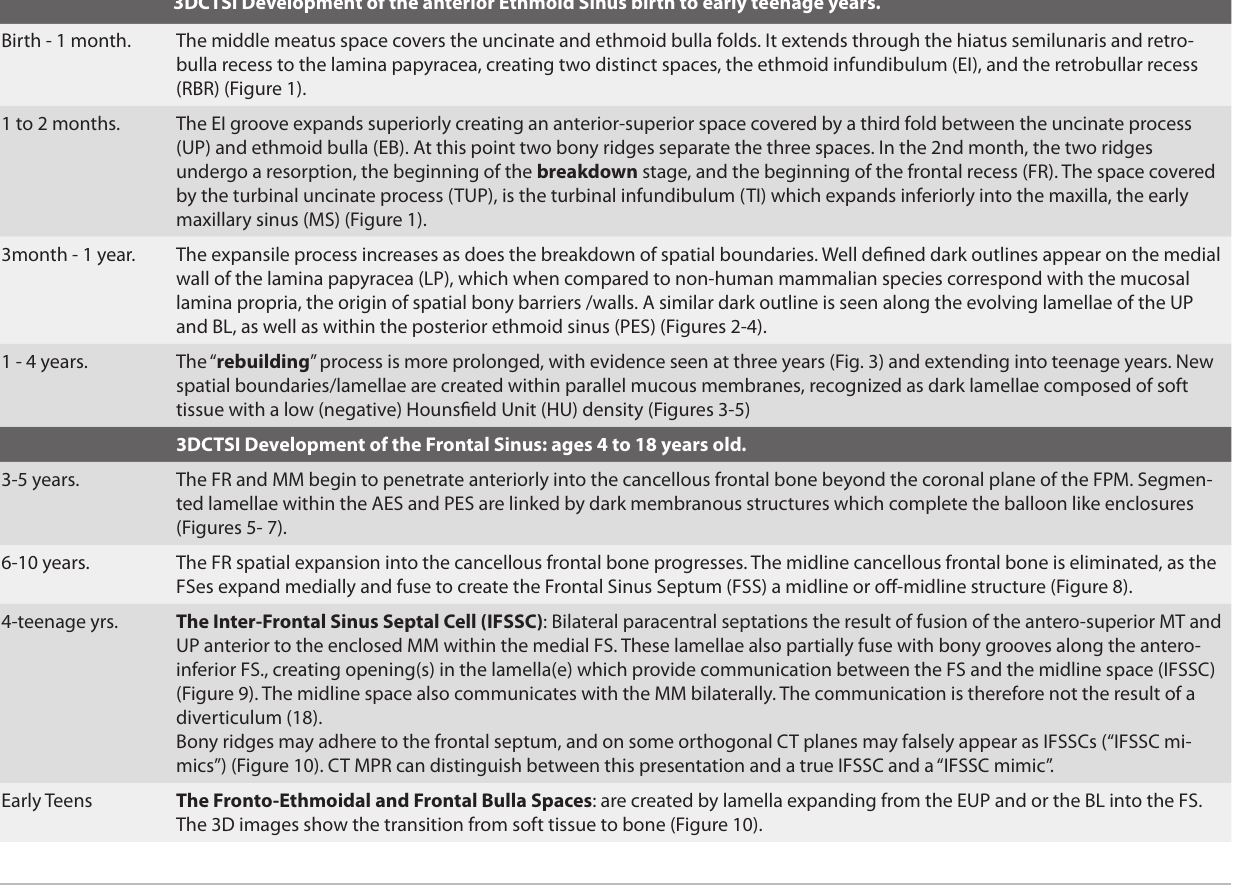
Table 2. Summary of 3DCTSI developmental